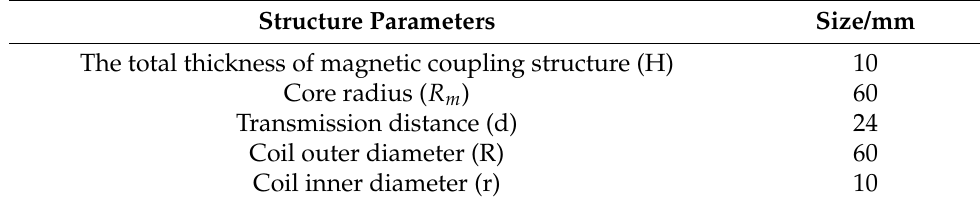
Table 1. Actual structure parameters of planar